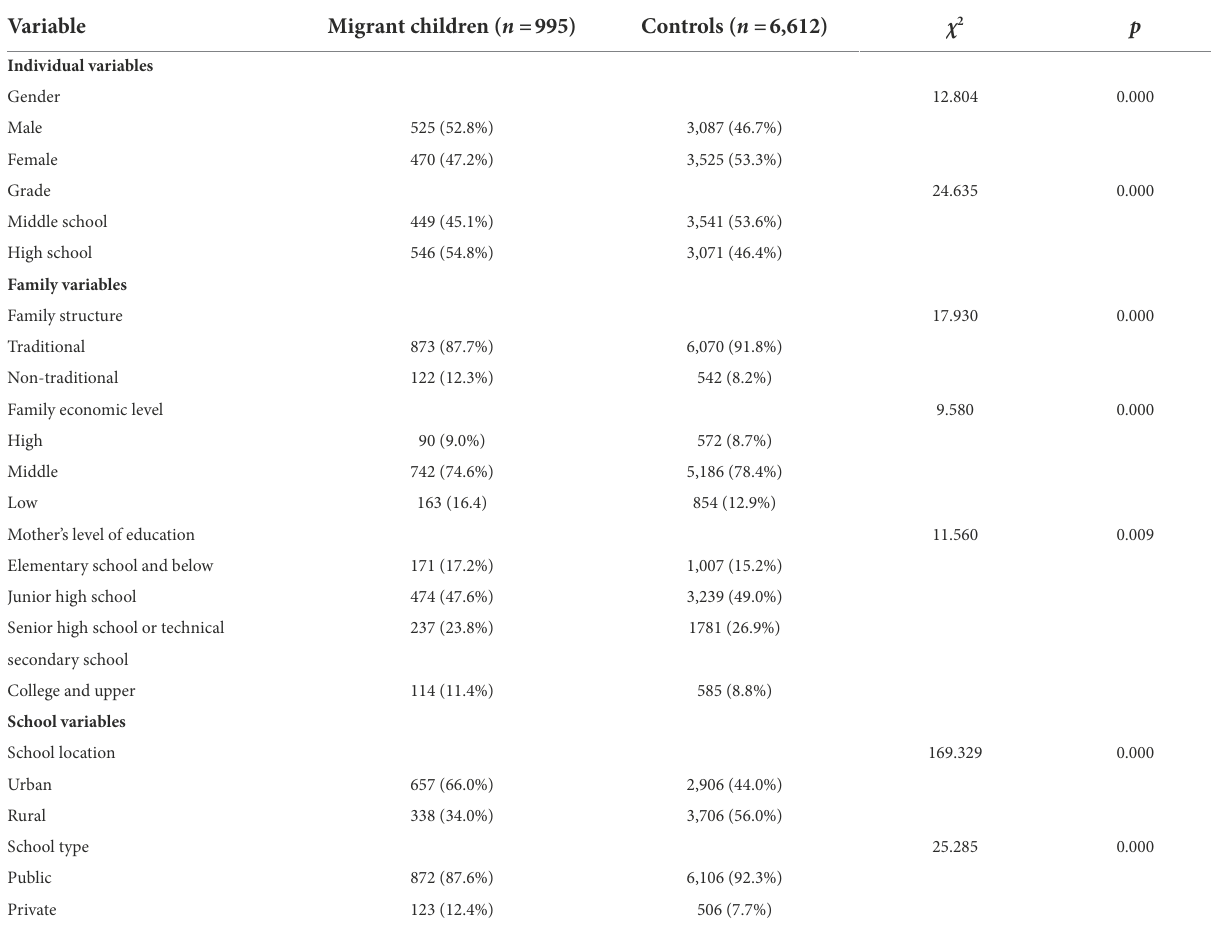
TABLE 1 Descriptive statistics for